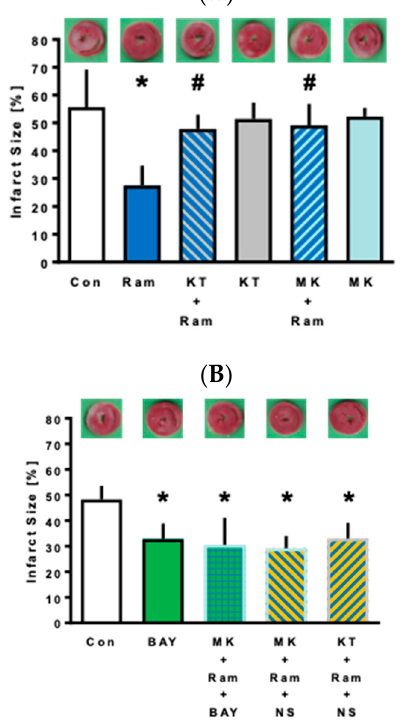
Figure 1. Infarct size measurement. Histogram shows the infarct size of part 1 (A) and part 2 (B) of the study. Data are presented as means ± SD, ( A ) * p < 0.0001 vs. Con, # p = 0.0012 KT + Ram vs. Ram, # p = 0.0005 MK + Ram vs. Ram. ( B ) * p = 0.0057 BAY vs. Con, * p = 0.0014 MK + Ram + BAY vs. Con, * p = 0.0006 MK + Ram + NS vs. Con, * p = 0.0063 KT + Ram + NS vs. Con.